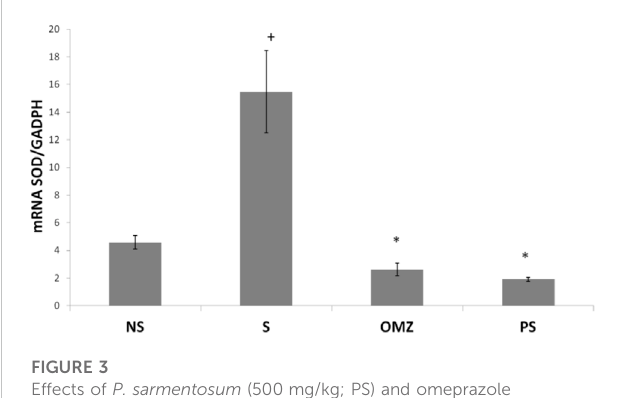
FIGURE 3 Effects of P. sarmentosum (500 mg/kg; PS) and omeprazole (20 mg/kg;OMZ)ongastric Sod mRNAlevelsinratsexposedtoWIRSfor 3.5 h.Barsrepresentmean±SEM( n =7).Key:+, p < .05comparedtothe non-stress (NS) control group; *, p < .05 compared to the stress (S) control group; #, p < .05 compared to the omeprazole-treated group.